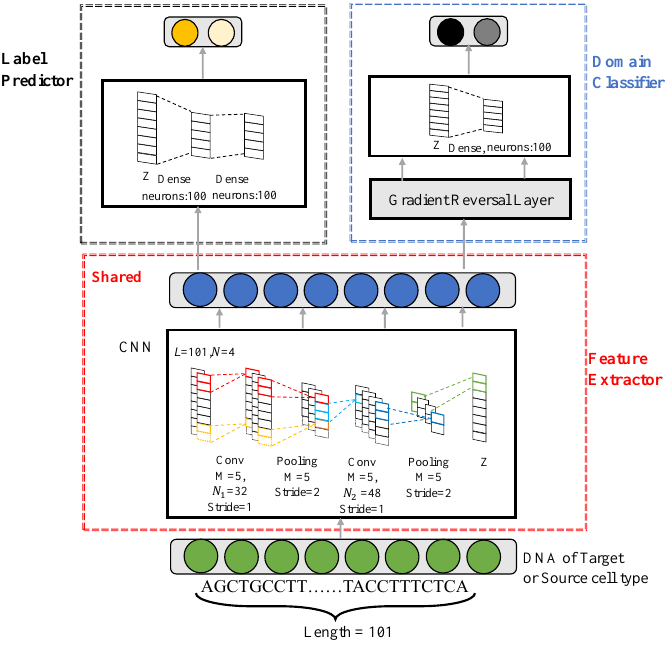
Figure 6. The framework of